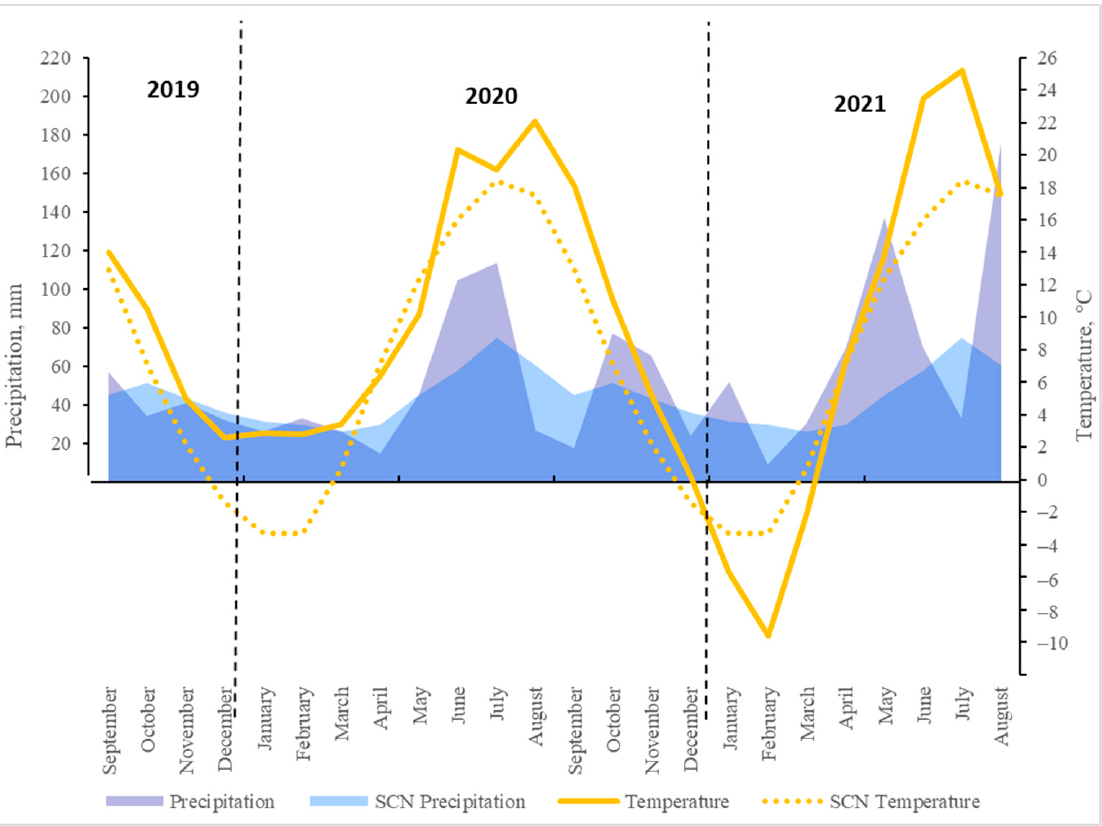
Figure 1. Meteorological conditions: monthly mean precipitation and temperature at the experimental site of the Joniskelis Experimental Station, LAMMC (SCN: standard climate norm, 1991–2020).